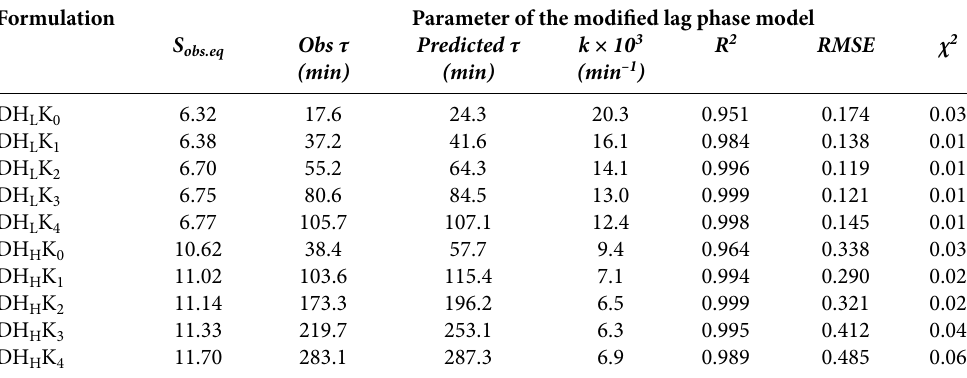
Table 3. Estimated parameters of the modified Lag phase model.